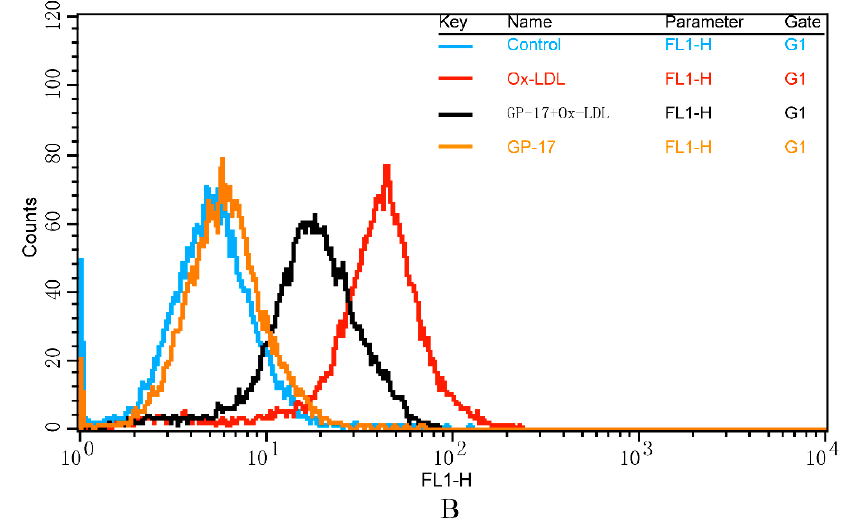
Figure 7. Effects of GP-17 on Ox-LDL-induced ROS production in HUVECs. ( A ) The ROS level was analyzed by fluorescence imaging; ( B , C ) Quantitative analysis of the fluorescence intensity of cells by flow cytometry. The values are expressed as the mean ± S.E.M. from three independent experiments. ## p < 0.01 vs. Control; ** p < 0.01 vs. Ox-LDL.